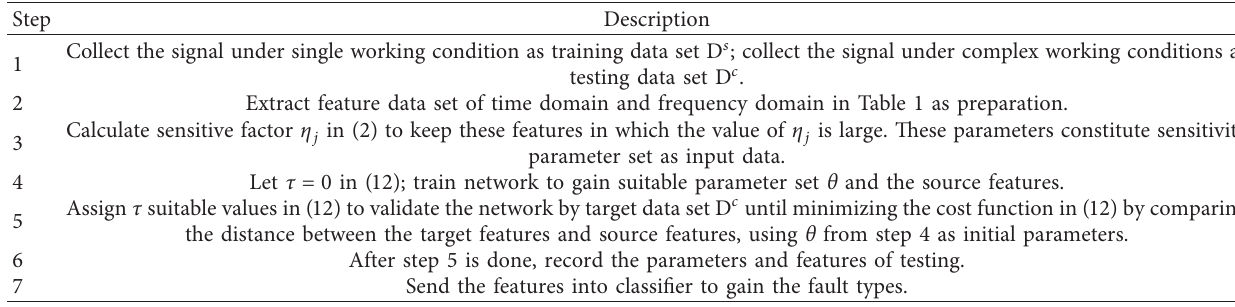
Figure 3: Fault diagnosis: (a) without sensitive features selection and transfer learning, (b) with sensitive features selection, without transfer learning, (c) without sensitive features selection, with transfer learning, and (d) with sensitive features selection and transfer learning. Table 2: Fault diagnosis process of the proposed algorithm.